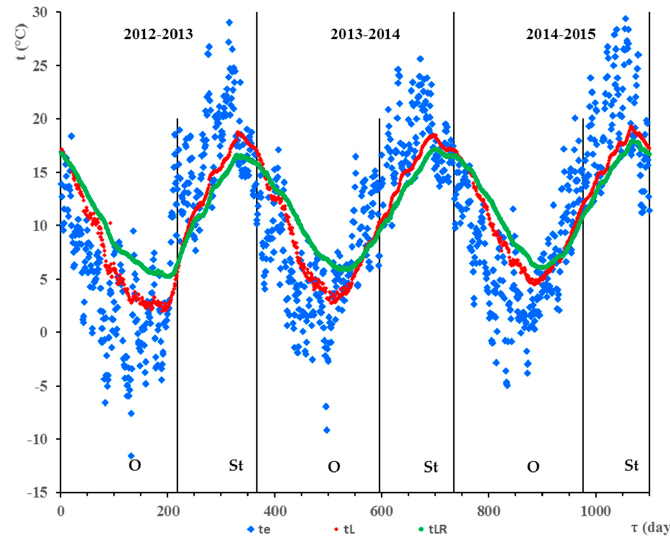
Figure 1. Ground mass temperatures in the area of linear HGHE ( t L ), reference ground mass ( t LR ) and ambient air temperatures ( t e ). O—operation of HGHE; St—stagnation of HGHE.